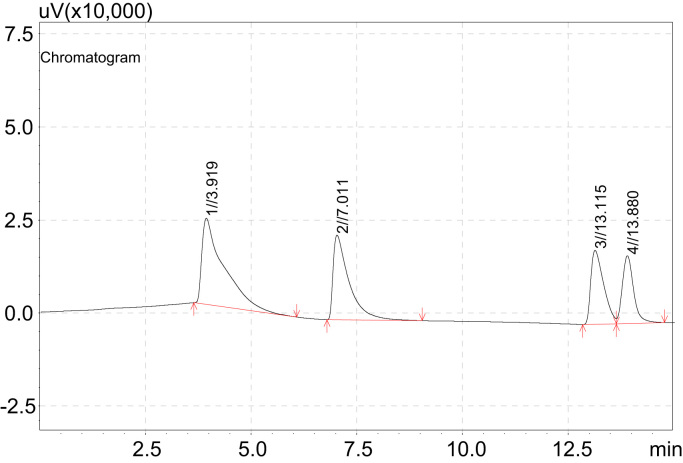
Sample standard.